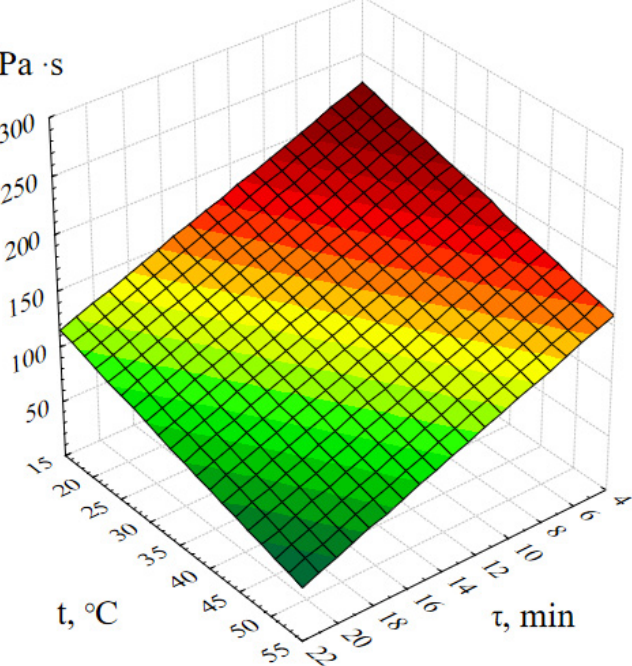
Figure 2. Response surface of the output parameter Y v (dynamic viscosity of the ZnO gel) depending on the temperature of the reaction medium and the duration of synthesis.